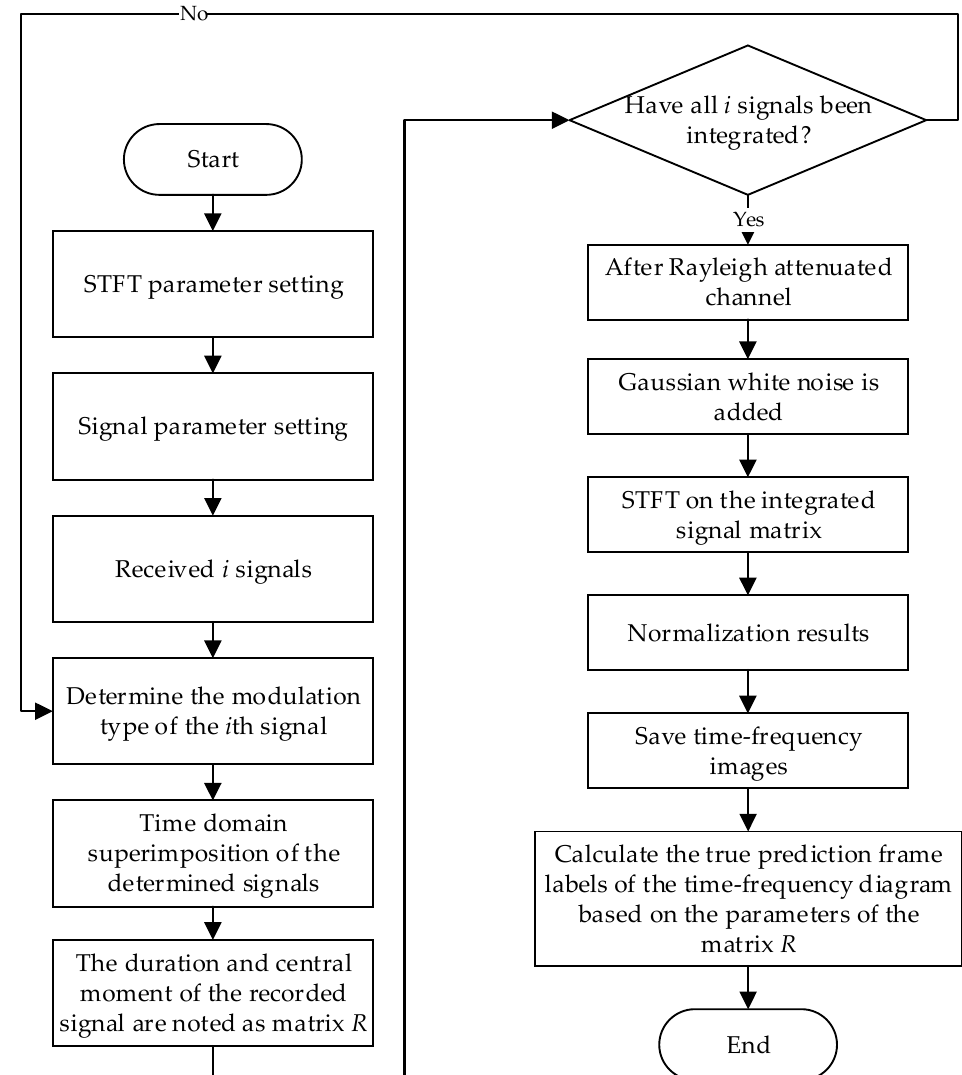
Figure 4. Block diagram of dataset generation and automatic annotation procedure.